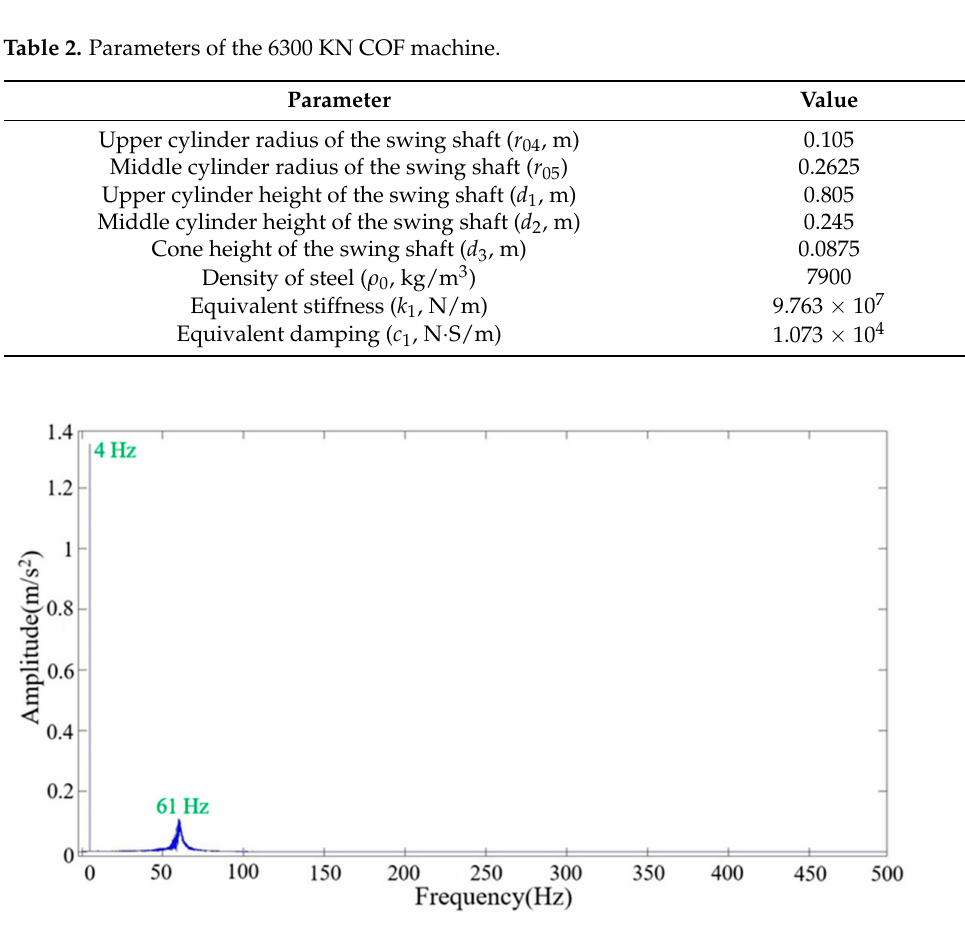
Figure 14. Vertical acceleration frequency-domain curve of the swing